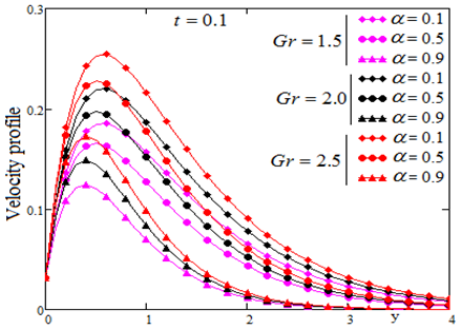
Figure 6. Profile of dimensionless velocity versus y for α variation with Pr = 0 . 7 , S = 5 , Sc = 0 . 8 , λ = 4 , Gm = 0 . 9 , M = 0 . 4 and different values of Gr